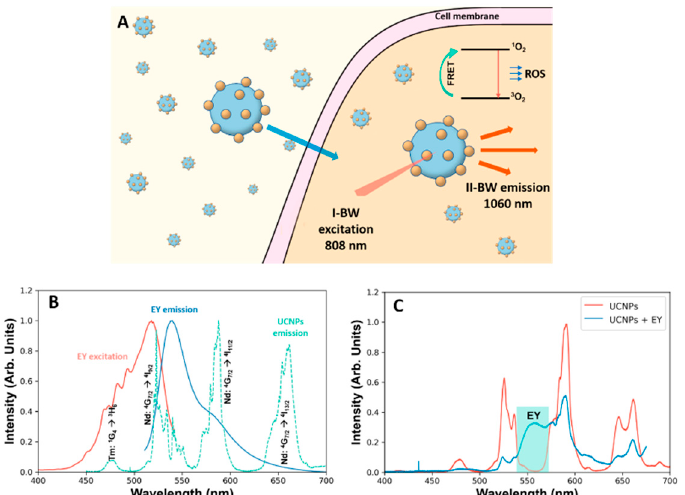
Figure 1. ( A ) Schematic drawing of the working process of EY-coated NPs at a cellular level. ( B ) Excitation spectrum (red) and emission spectrum (blue) of EY. The emission of the UCNPs is also included in the graph (green). ( C ) Emission spectra of a solution of UCNPs and a solution of UCNPs + EY where the quenching effect can be observed especially at the Nd: 4 G 7/2 “ 4 I 9/2 and Nd: 4 G 7/2 ” 4 I 11/2 transitions.